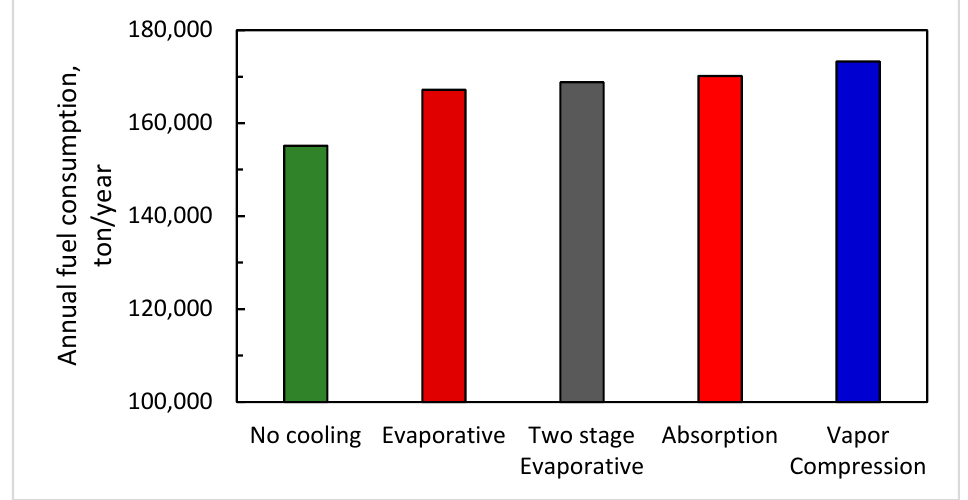
Figure 19. Annual fuel consumption of different inlet cooling systems.